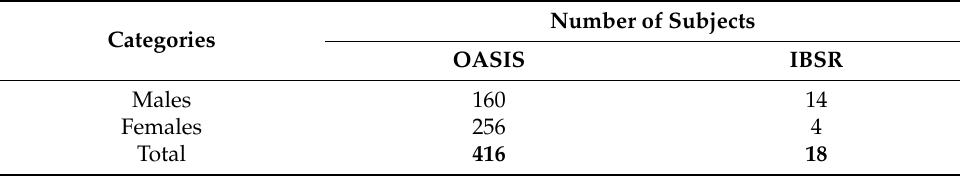
Table 1. Details of OASIS and IBSR